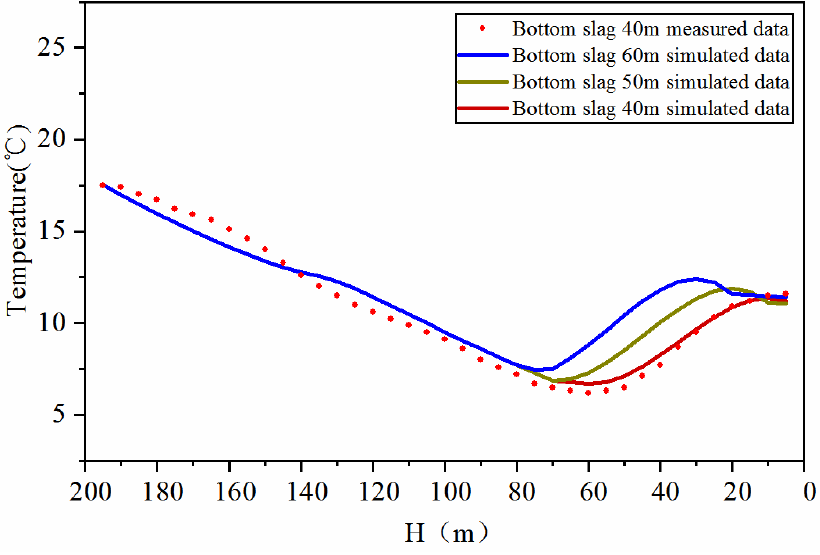
Figure 7. Water temperature of bottom slag of different thicknesses in Xulong Reservoir.